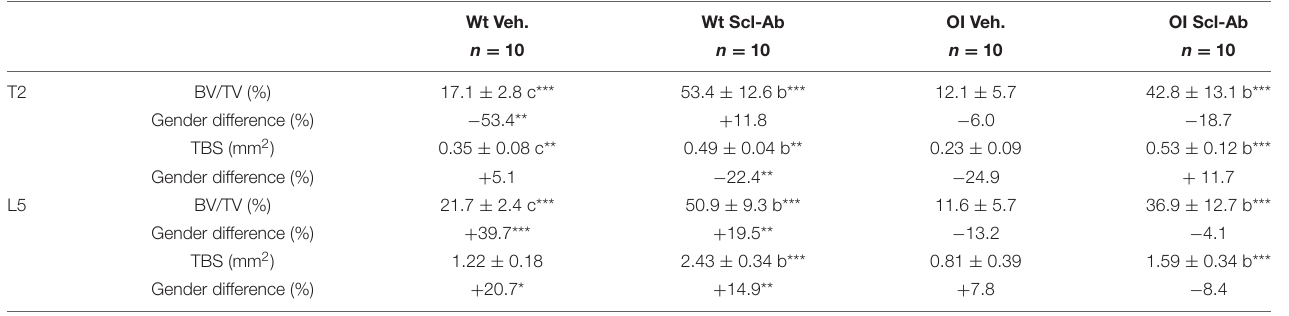
TABLE 3 | Trabecular bone volume/total volume (BV/TV) and trabecular bone sectional area (TBS) in vertebral body of T2 and L5 measured in microradiographs of sagittal sections through the spine in male wild-type (Wt) and oim/oim (OI) mice after 9-week treatment with either Scl-Ab or vehicle (Veh.). Wt Veh. Wt Scl-Ab OI Veh.